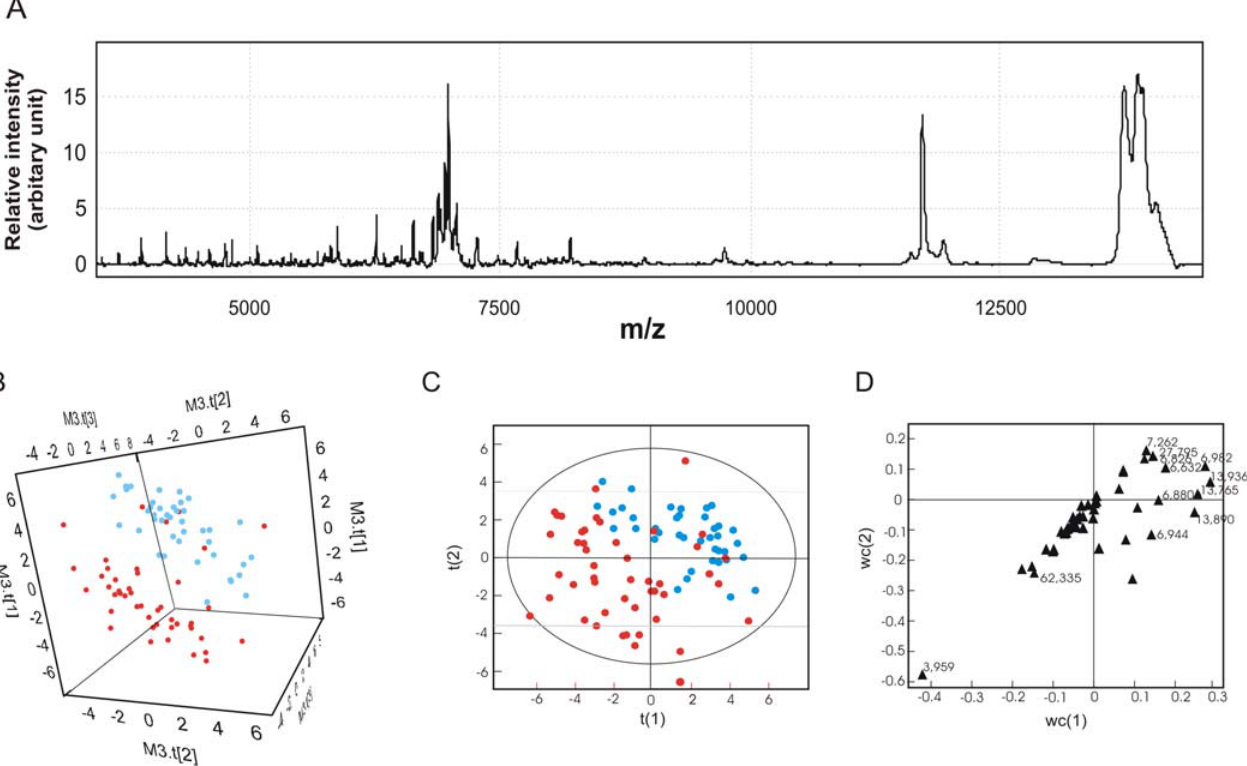
Figure 1. Protein/Peptide Profiling of CSF Samples from First-Onset, Drug-Naı¨ve Schizophrenia Patients Using SELDI Mass Spectrometry (A) Typical CSF protein/peptide spectrum using an anion exchanger chip (Q10; 50 mM Tris-HCl [pH 9.0]) showing the m/z range of 2,500–15,000 from a healthy volunteer is shown. (B) The peak intensity of protein/peptide peaks from SELDI spectra were analyzed using PCA and PLS-DA models. A 3D PLS-DA scores plot indicates clusters of healthy volunteers (in blue) and untreated, drug-naı¨ve schizophrenia patients (in red). (C) and (D) PLS-DA scores and loadings plots. The scores plot is similar to (B) but only the first two components were used to discriminate between healthy controls and patients. The loading plot as shown in (D) indicates the key protein/peptide peaks contributing the most towards the separation as shown in (C). The 3,959-Da VGF23–62 peptide was found to predominantly contribute to the separation between the two groups.